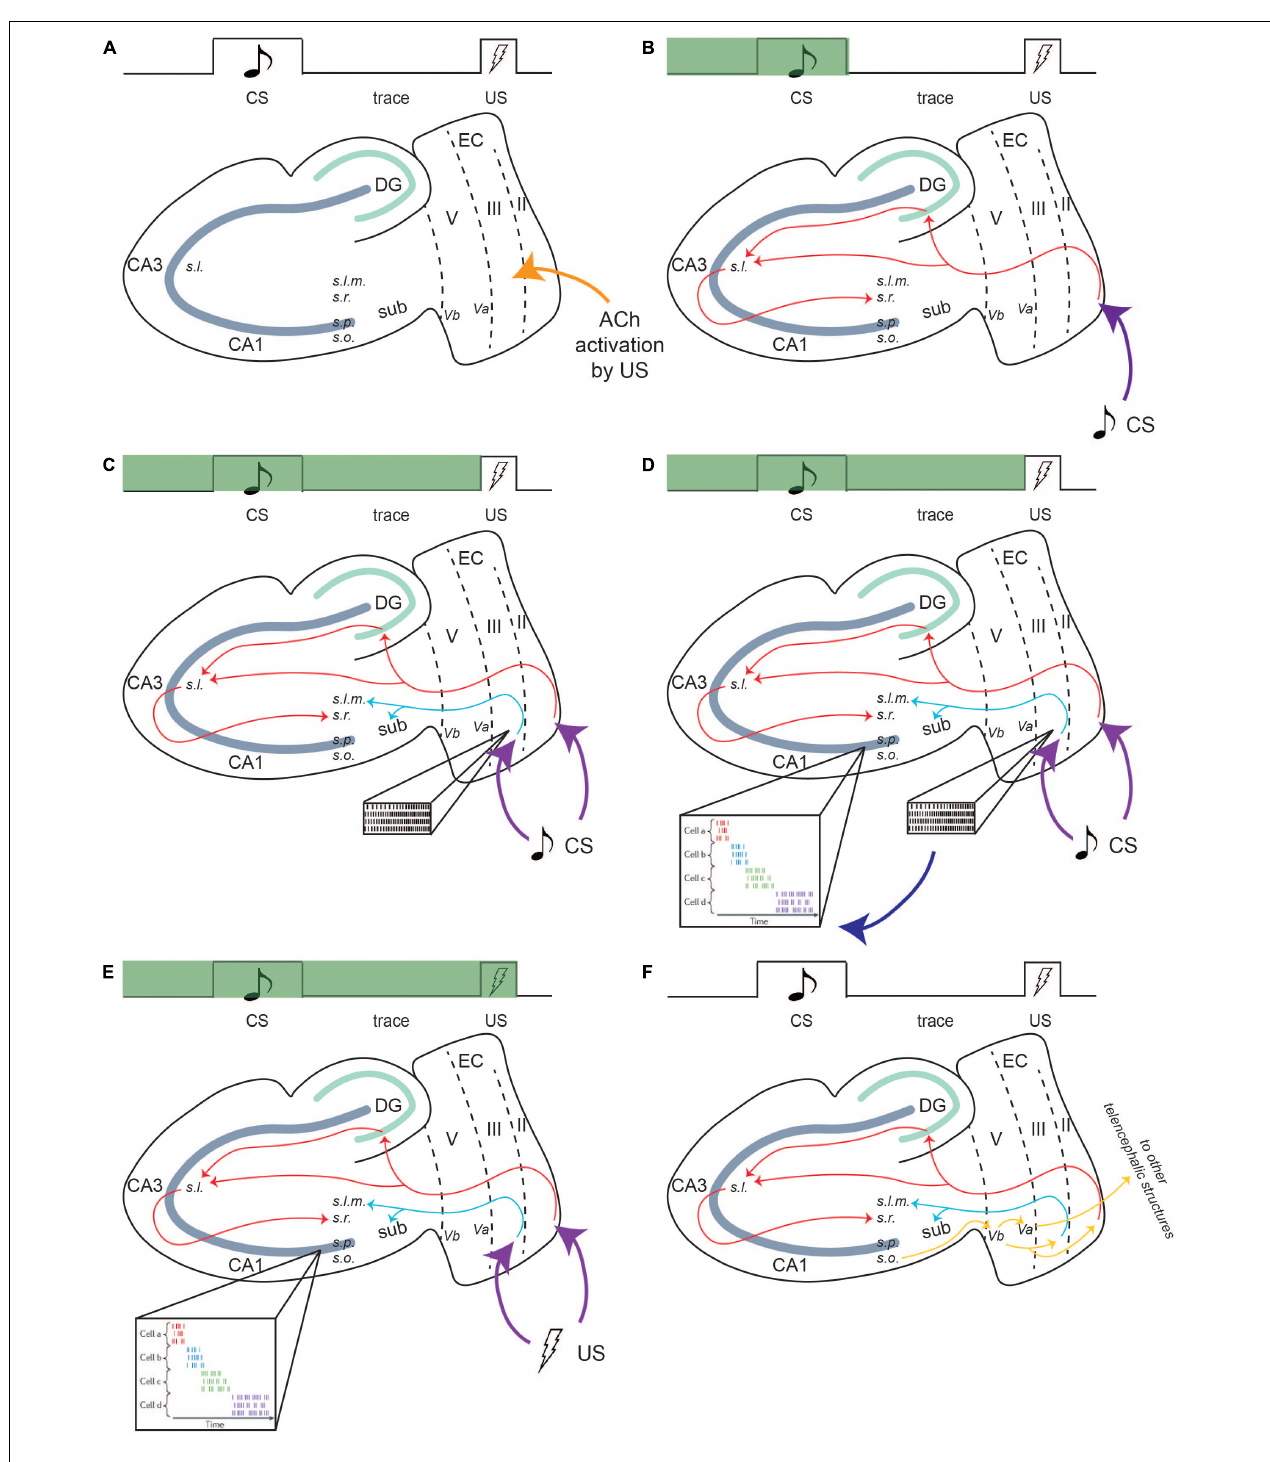
FIGURE 4 | Persistent firing bridges the trace period in tEBC. Green bar indicates progress during a single trial of tEBC. In this example, the CS is an auditory tone and the US is a mild electrical shock to the periorbital area. Due to its saliency, the US activates cholinergic innervation to the LEC region (A) . Then, CS information projects to the CA1 region of the hippocampus via the PF path (B) . For the mental trace of the CS to be maintained, the CS also activates persistent firing in LEC III. LEC III projects directly to CA1 via the TA pathway (C) , which puts it in a prime position to stimulate and sustain CA1 activity throughout the trace interval. LEC III persistent firing may activate time cells in the CA1 region, which develops firing patterns time-locked to sequential moments of the trial (D) , time cell activity adapted from Eichenbaum (2014). The activity of time cells bridges the trace interval and can maintain the CS information during the interval until US information arrives (E) . Following the acquisition of tEBC, the learned behavior is projected via output pathways to be consolidated into long-term storage (F) . From Lin (2020).